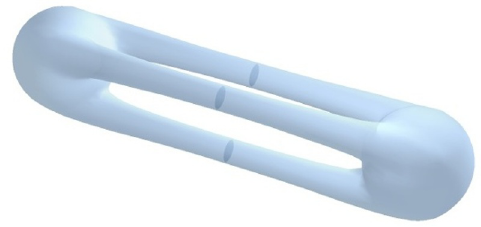
Figure 4 . The low-temperature or long-cylinder limit of the genus-two